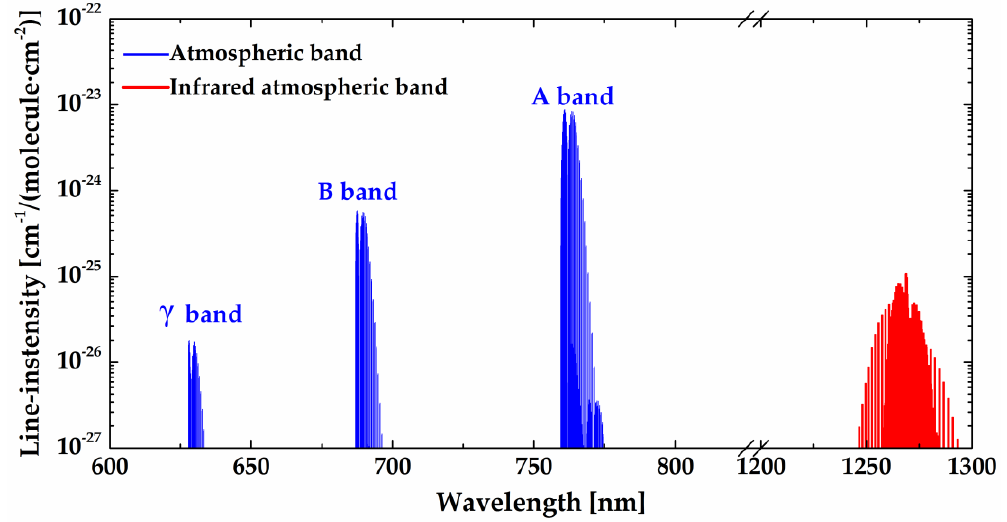
Figure 1. The absorption line strength and spectral distribution of the O 2 infrared atmospheric band and the O 2 atmospheric band (from HITRAN [13]).